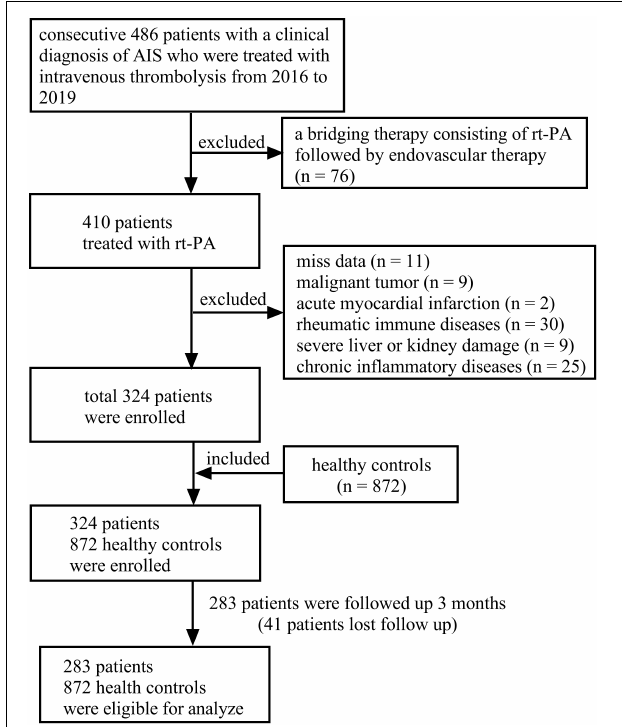
FIGURE 1 | Flow diagram showing the patient selection